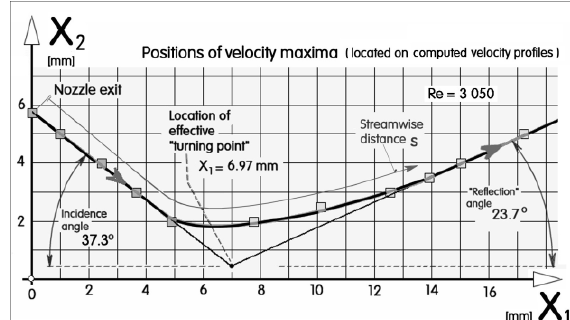
Fig. 13. Mutually connected computed locations of the points in which the jet flow has its local velocity maximum. The angle of reflection at right is smaller than the impingement angle at left, but the difference between them may be considered